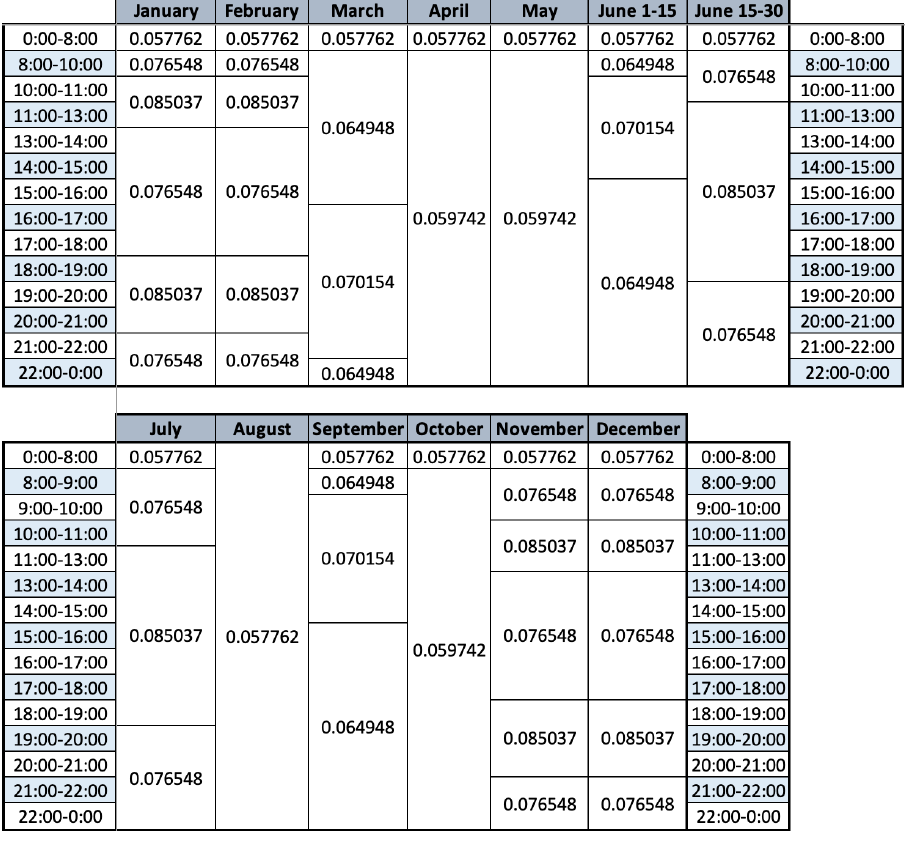
Figure 6. Electricity billing